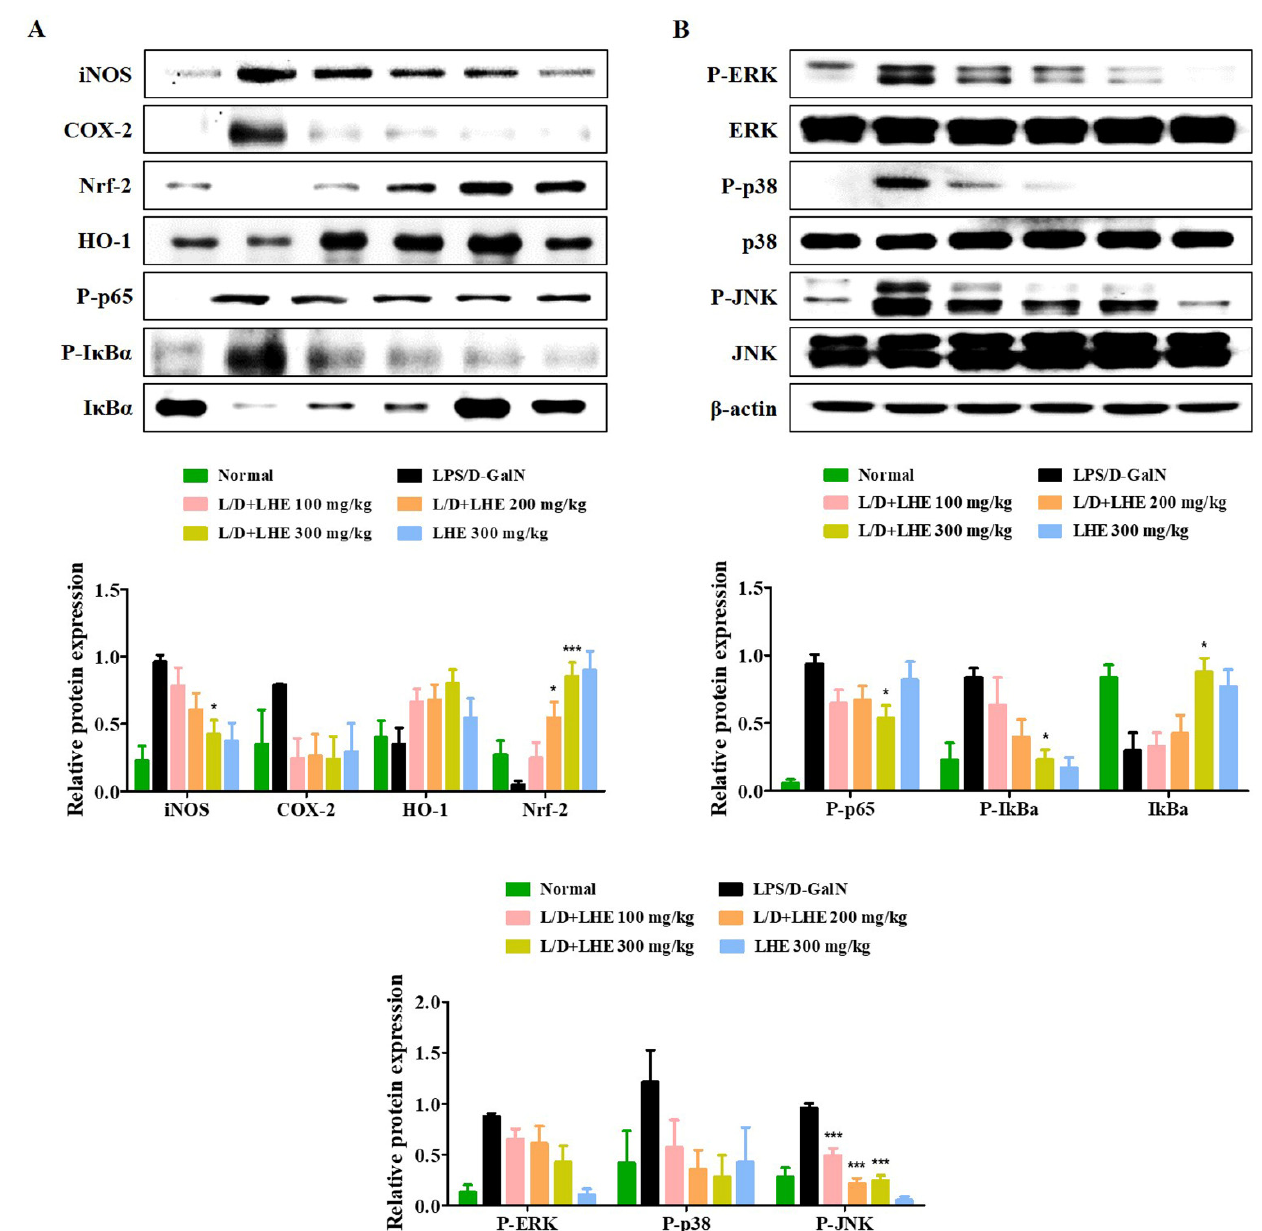
Figure 6. Effects of LHE on ( A ) the expression of iNOS/COX-2, induction of HO-1/Nrf-2, activation of NF- κ B, and ( B ) phosphorylation of MAPK in LPS/D-GalN-induced hepatitis mouse model. Mice were pretreated with LHE or vehicle once per day for 6 days. Then, LPS/D-GalN was injected 1 h after the last administration. After 6 h, mice were sacrificed, and liver tissue samples were collected. The expression of inflammatory synthetic enzyme, antioxidant molecules, and inflammatory pathways were determined via Western blot analysis. The histograms showed the expression levels of protein relative to those of β -actin. * p values of < 0.05, and *** < 0.001 (vs. LPS/D-GalN) were statistically